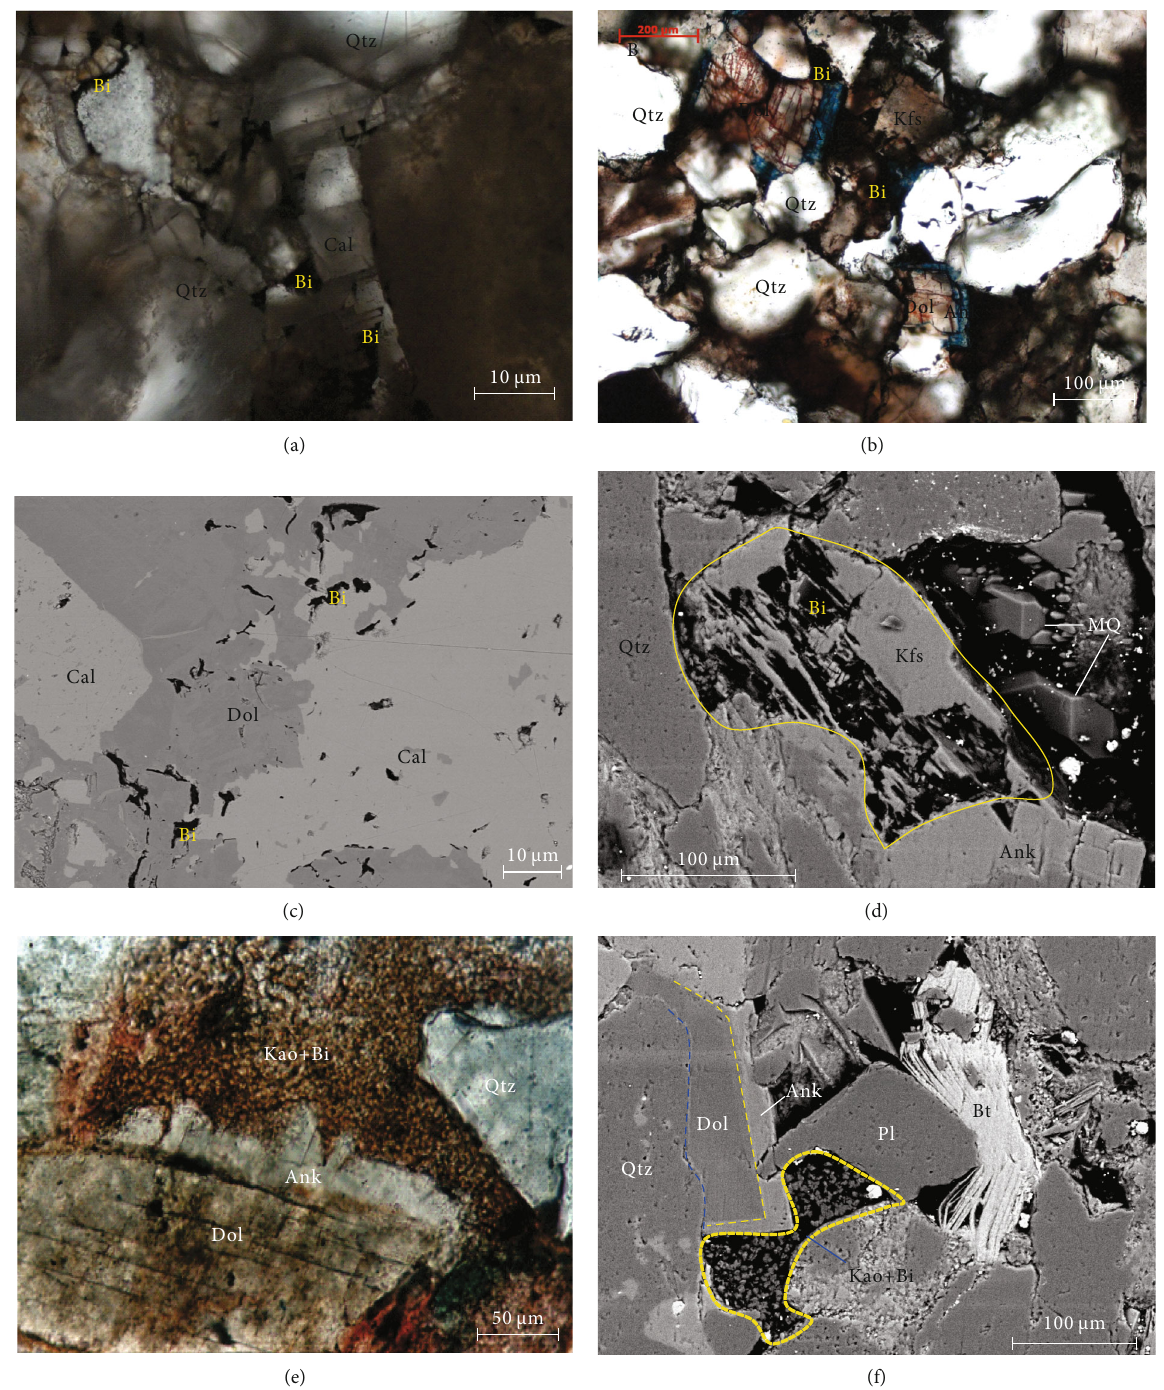
Figure 6: Representative photomicrographs of bitumen and residual oil occurrence in the reservoir of the Kela 2 gas fi eld. (a) Residual pores and intergranular calcite cement and residual bitumen, plane-polarized light. (b) Intergranular dolomite and ankerite cement and residual bitumen, plane-polarized light. (c) Bitumen in internal pores within calcite and dolomite, FE – SEM image. (d) Bitumen in K-feldspar dissolution pores, BSE image. (e) Pore- fi lling kaolinite and bitumen in residual pores after dolomite and ankerite formation, plane- polarized light. (f) Pore- fi lling kaolinite and bitumen, coeval with microquartz grains, BSE image. Qtz: quartz; Kfs: K-feldspar; Dol: dolomite; Cal: calcite; Bi: bitumen; Ank: ankerite; Kao: